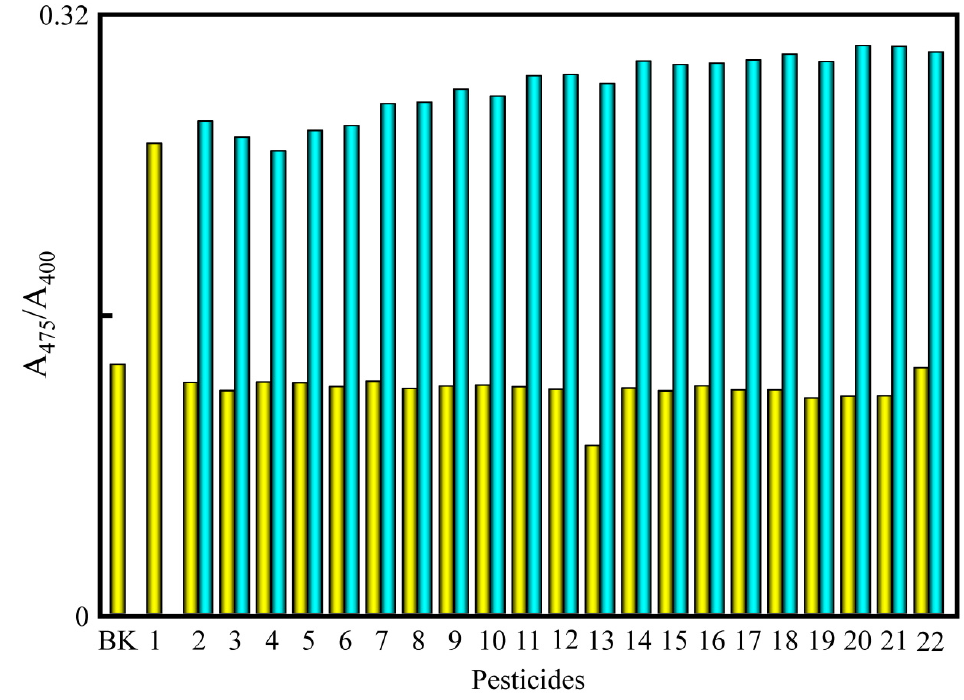
Figure 5. Absorption ratio (A 475 /A 400 ) of SA-AgNPs for dimethoate over other pesticides (yellow bar) and the mixture of dimethoate with other pesticides (blue bar). BK: background; 1 to 22 are various pesticides (i.e., dimethoate, trichlorfon, dichlorvos, chlorothalonil, chlorpyrifos, glufosinate-ammonium, methomyl, 2,4-D(sodium), propanil, glyphosate, dicofol, carbaryl, fenvalerate, thiodicarb, acetamiprid, kresoxim-methyl, carbofuran, pencycuron, profenofos, imidacloprid, bifenthrin, carbendazim). Various concentrations of dimethoate ranging from 0 to 10.0 ppm were examined under optimal conditions to show the performance of the sensing system. UV–vis absorption spectroscopy monitored the variations in colorimetric response at the absorption ratio (A 475 /A 400 ) of SA-AgNPs upon adding dimethoate. The concentration of dimethoate increases and the absorption ratio (A 475 /A 400 ) of SA-AgNPs increases over a wide range of concentrations (0.05–2.0 ppm), as shown in the inset of Figure 6. The change in absorption ratio (A 475 /A 400 ) plot against the dimethoate concentration from 0.05 to 2.0 ppm gave a straight line with R 2 = 0.9983. The LOD of dimethoate was calculated from the standard deviation ( σ ) of the blank ( n = 10) and slope (s) of the calibration curve using the following equation